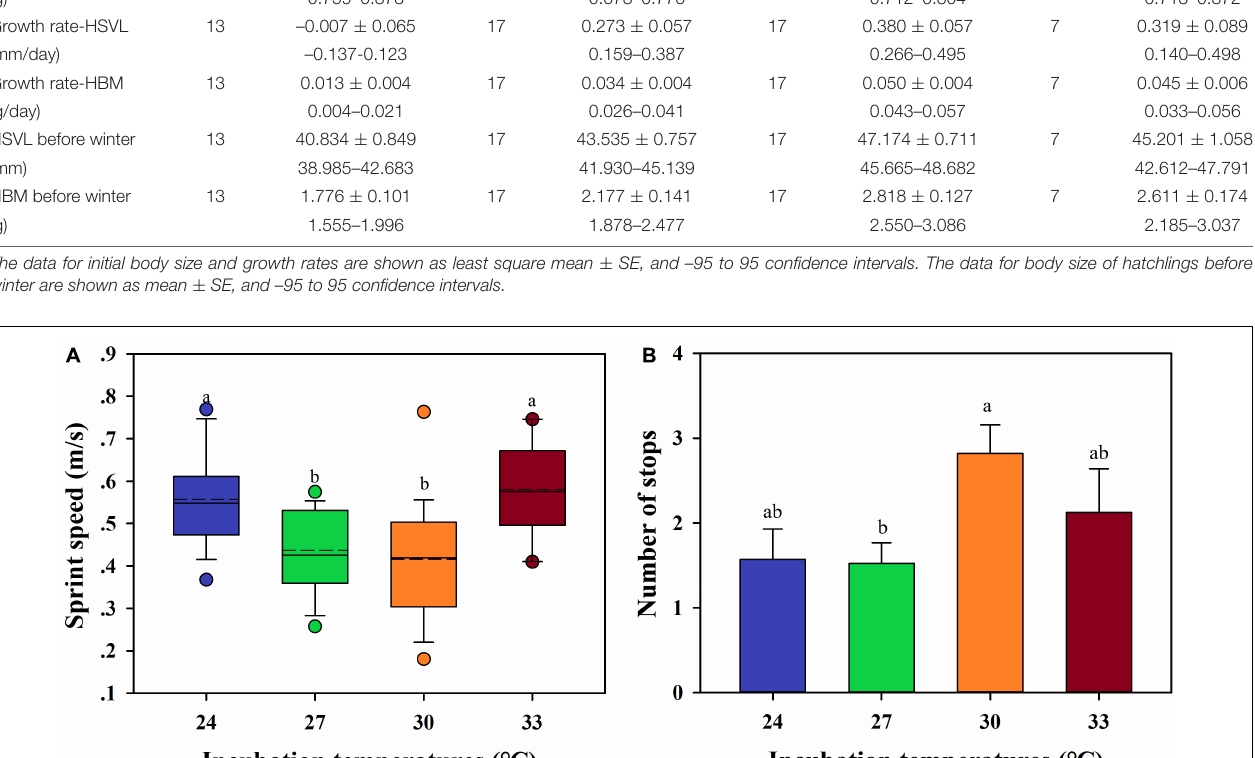
Frontiers in Ecology and Evolution |